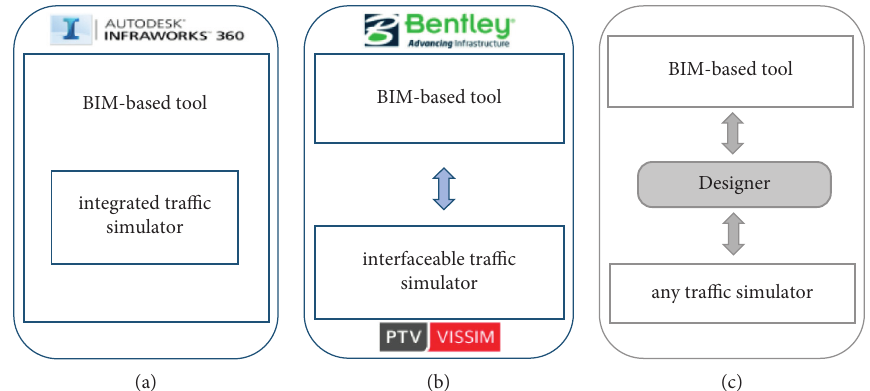
Figure 3: Alternative options for designer engineers: (a) customised integrated solution; (b) customised interfaceable solution; and (c) standard solution.